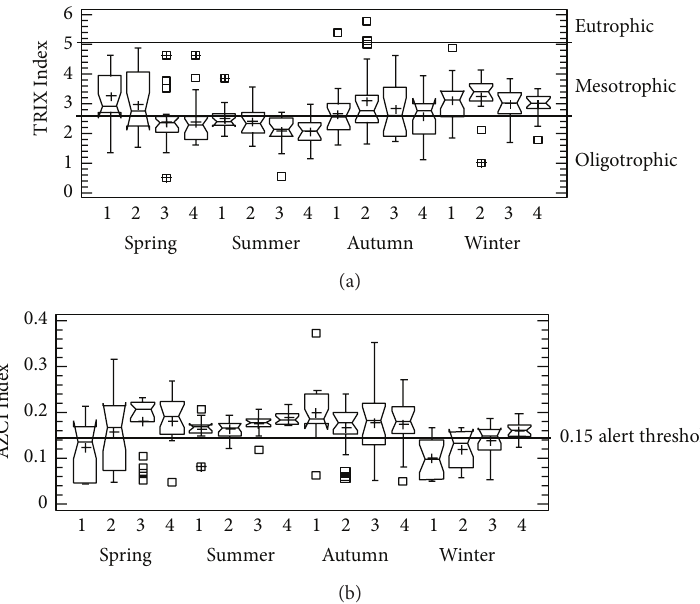
Figure 3: Box and whisker plot of the (a) TRIX, and (b) AZCI for La Salada Cove during seasons. Numbers 1 to 4 represent the transects. Median, quartiles, ranges, and outliers of data are shown for each event. It shows levels of trophic state and water quality influences from urban sewage